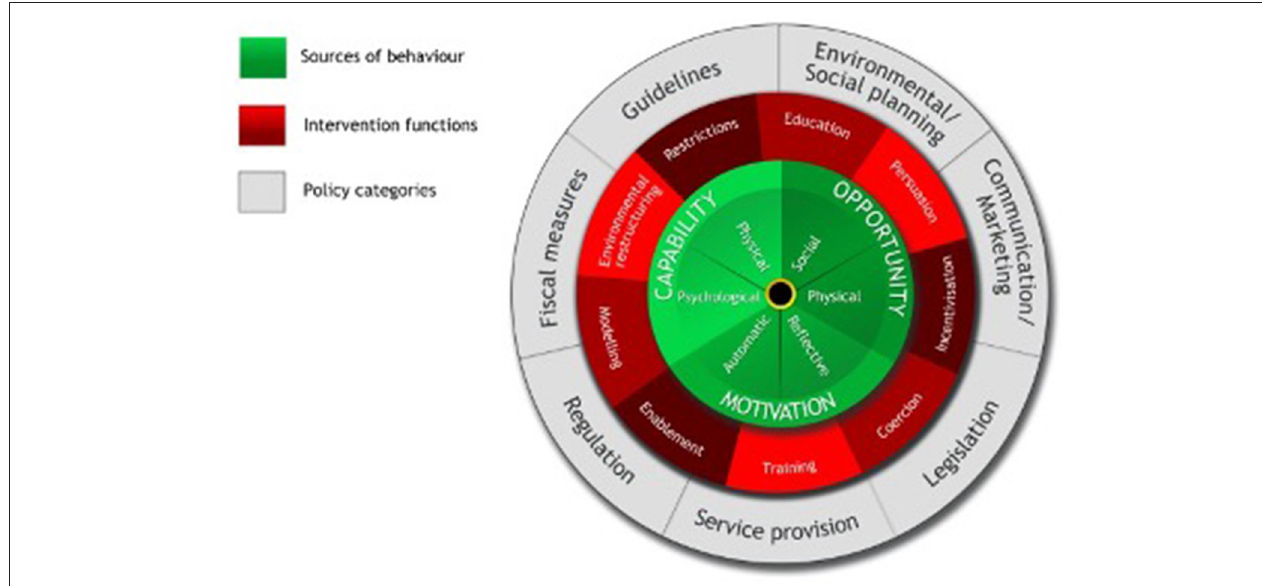
FIGURE 1 | Behavior change wheel